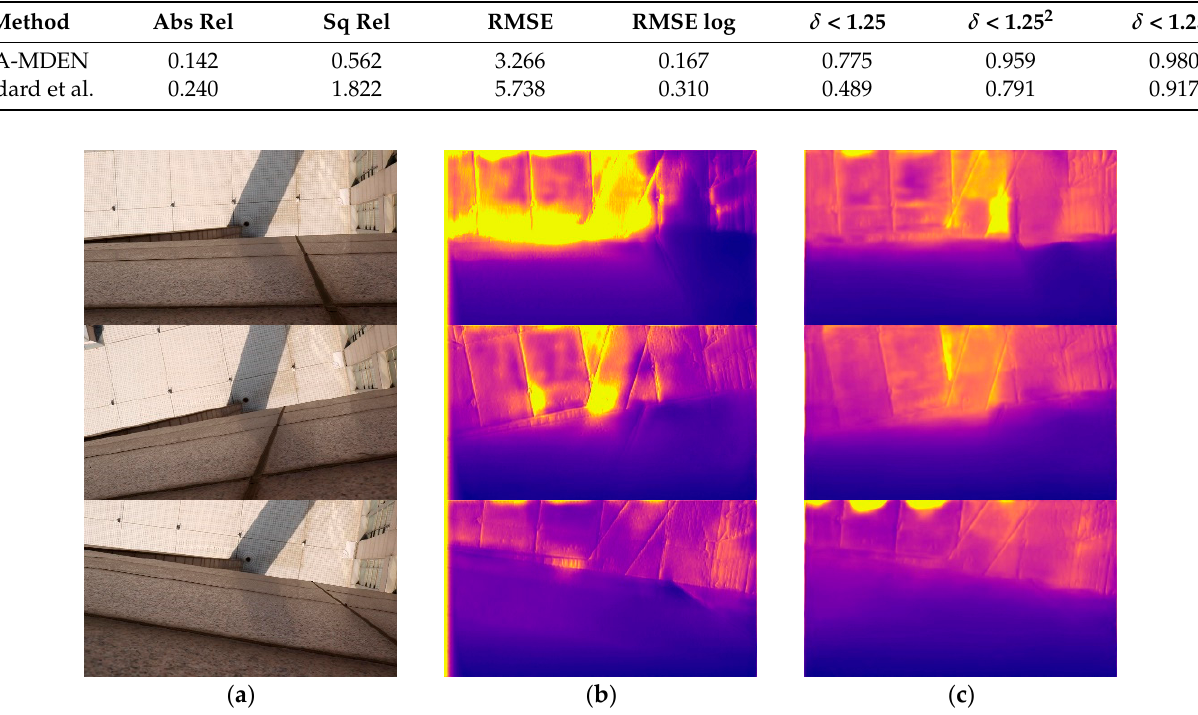
Figure 8. Qualitative samples on the BHDE-v1 dataset. ( a ) The input RGB images, ( b ) outputs of Godard et al. [29], and ( c ) outputs of the proposed SFA-MDEN.